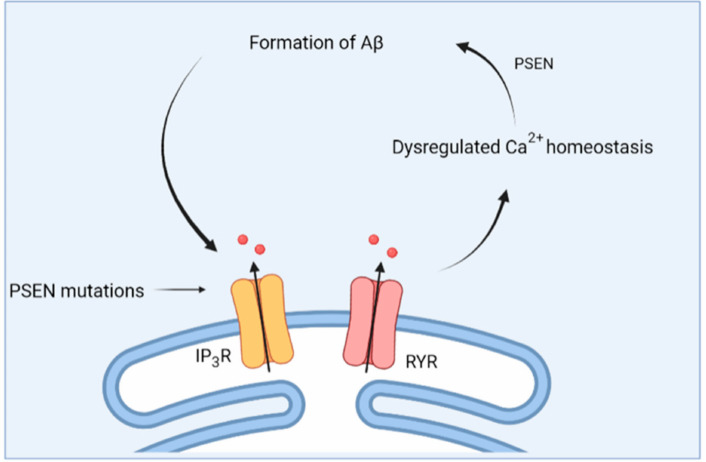
Figure 3. Schematic overview of the feed forward interplay between Ca 2+ signaling and A β . Mu- tations in presenilin (PSEN) cause dysregulations in Ca 2+ homeostasis, which then causes altered processing of APP and the formation of A β . In turn, this further impacts Ca 2+